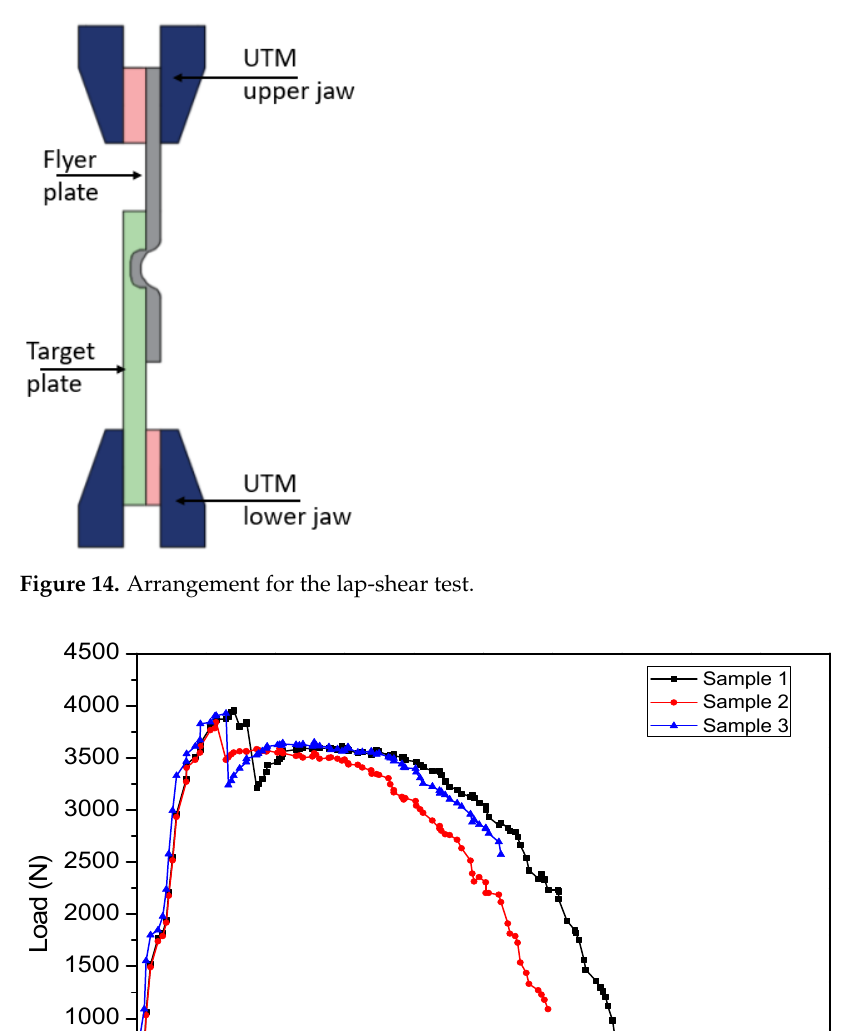
10 of 17 Figure 13. Result of the peel test at 8 kJ of discharge energy.